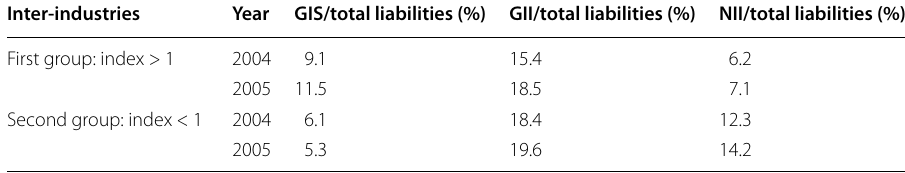
Table 14 GIS, GII, and NII bifurcated by sign of power of dispersion index in the asset-ori- ented system